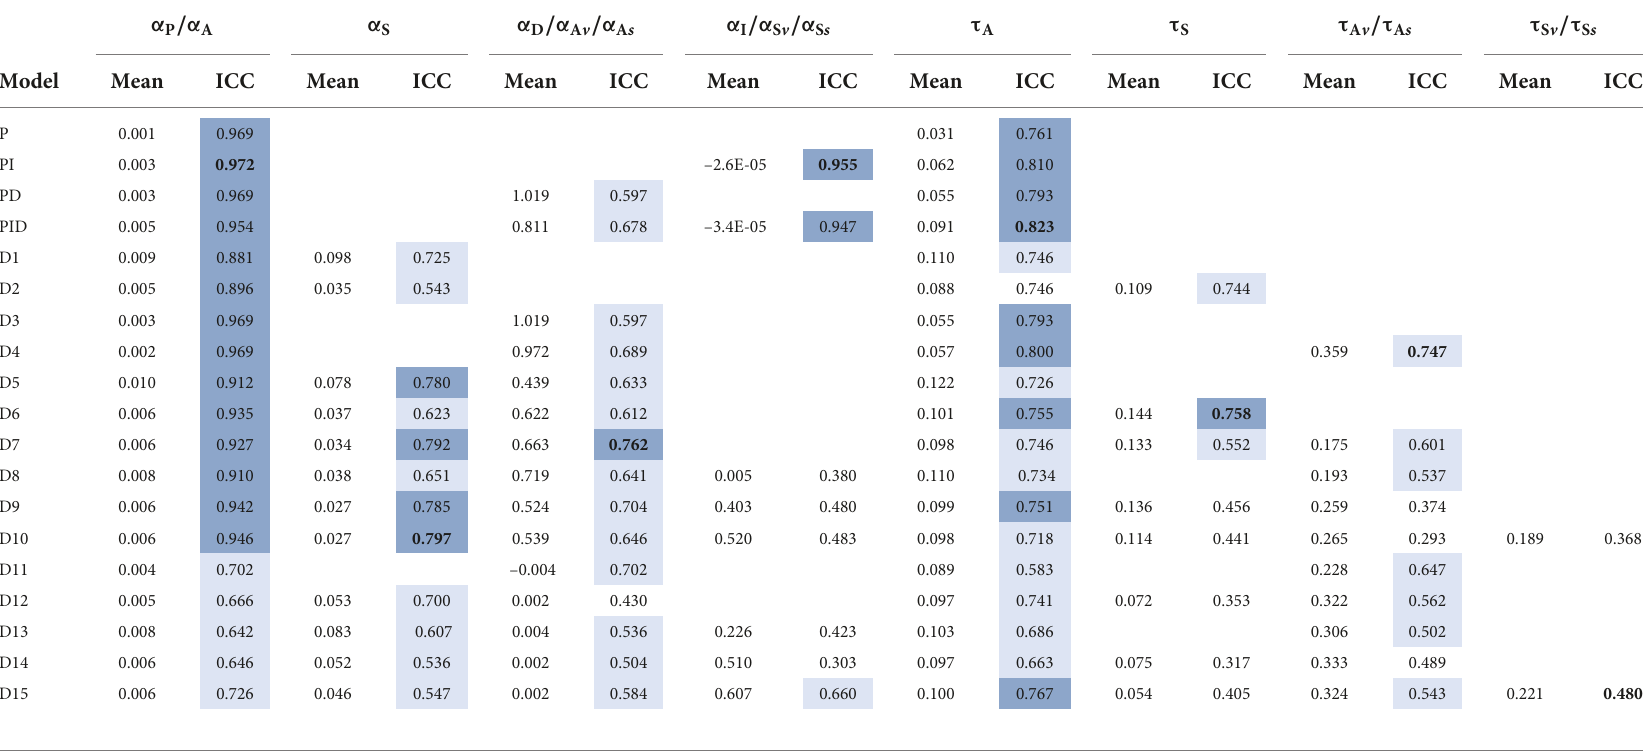
TABLE 4 Study 2 mean values and ICC of optimized parameters in cross-validation